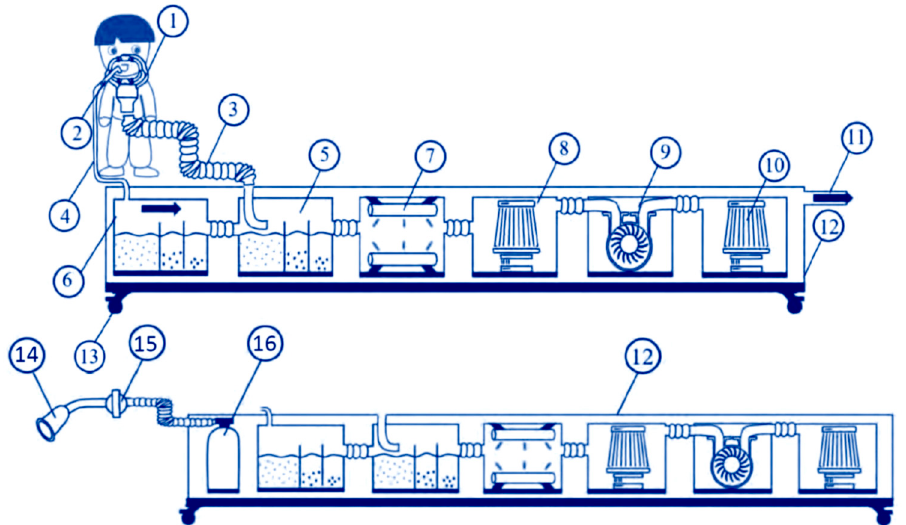
Figure 7. Comparison of the basic assumptions of the conservative STOP strategy and the offensive SPEC strategy.